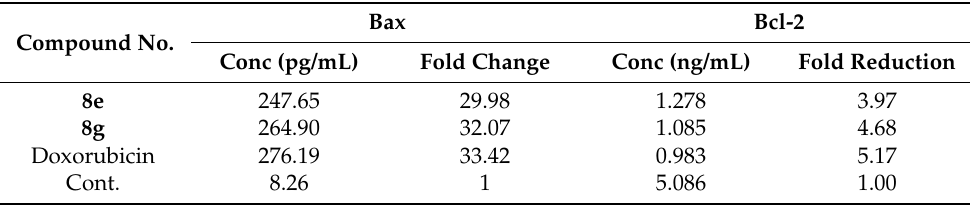
Table 5. Bax and Bcl-2 levels for compounds 8e , 8g, and Doxorubicin in MCF-7 breast cancer cell line. Compound No.